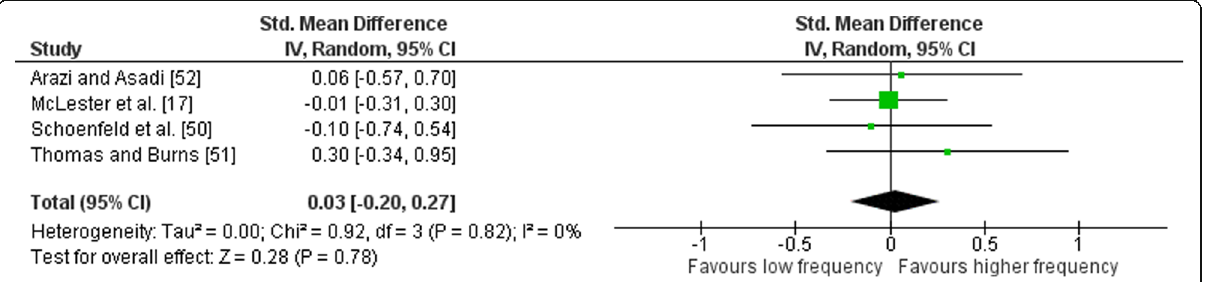
Fig. 9 Low vs. high weekly training frequency. Pre- vs. post-mean ES strength difference on volume-equated multi-joint and isolation exercise. The vertical line indicates the overall estimate of combined multi-joint and isolation studies pre- vs. post-mean ES strength difference. Horizontal lines indicate 95% CI, squares estimates, whereas square size is proportional to sample size, and rhombs ’ meta-analytically pooled